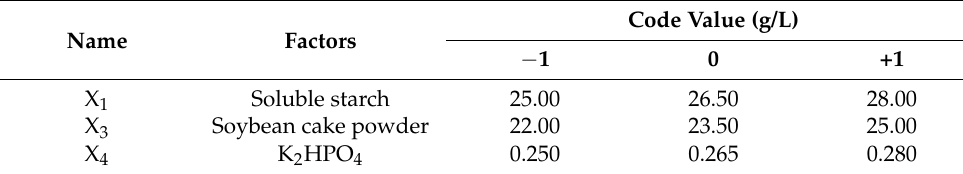
Table 2. The level and code of variables chosen for